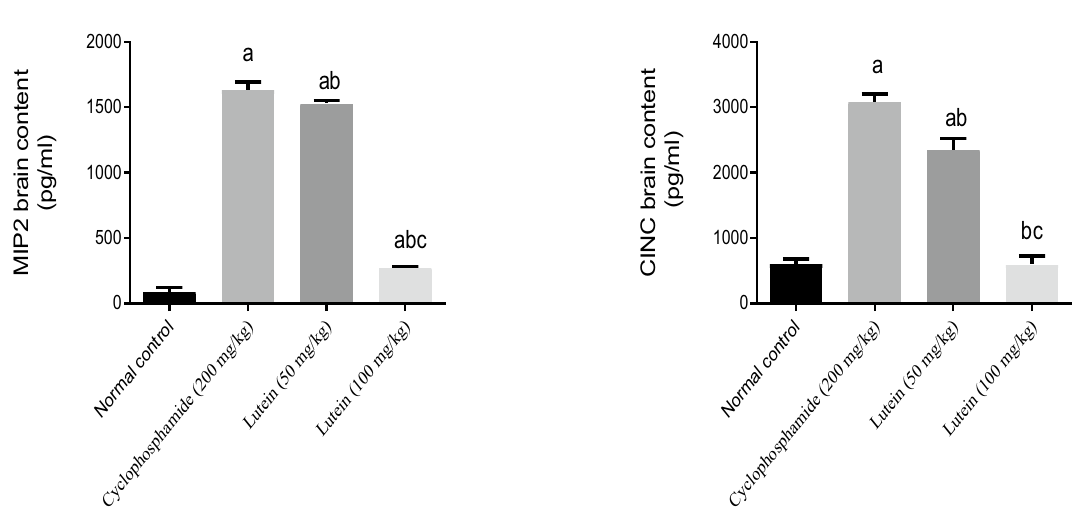
Figure 5. Effects of lutein on MIP2 and CINC brain contents. a Significant compared to the control group. b Significant compared to the Cyclophosphamide group. c Significant compared to Lutein 50 group at P <